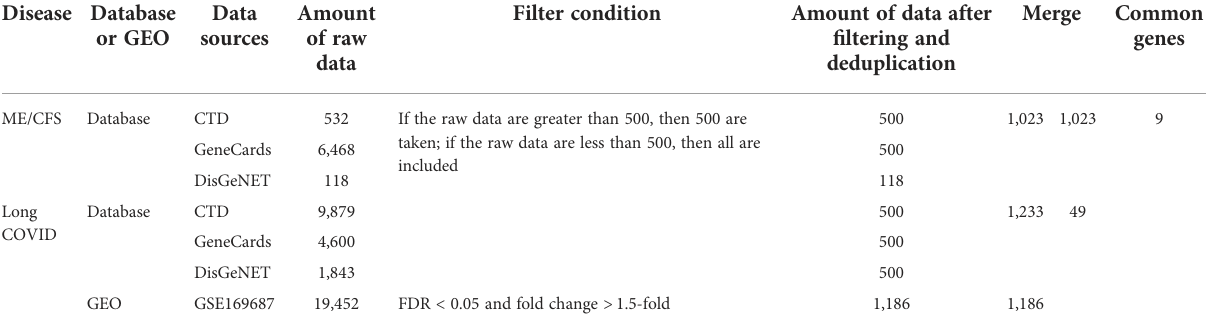
TABLE 1 Collection of Long COVID and ME/CFS-related